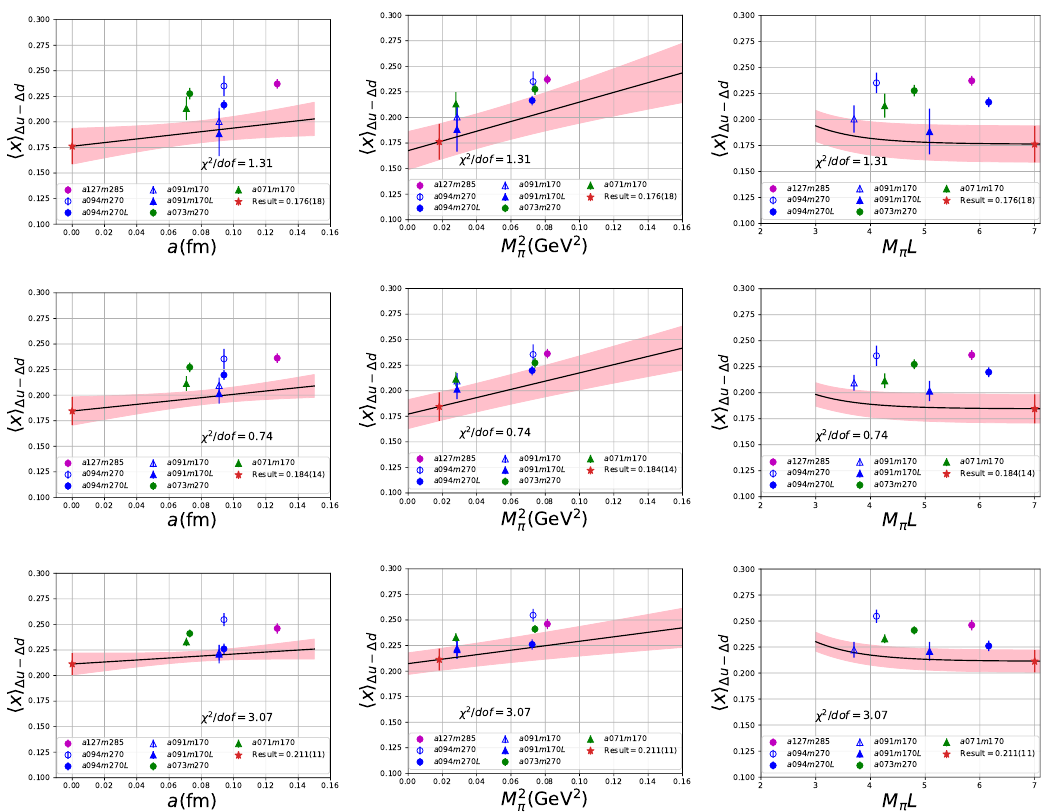
Figure 2 . Data for the helicity moment h x i ∆ u − ∆ d from the seven ensembles renormalized using method A in the MS scheme at µ = 2 GeV. The rest is the same as in figure